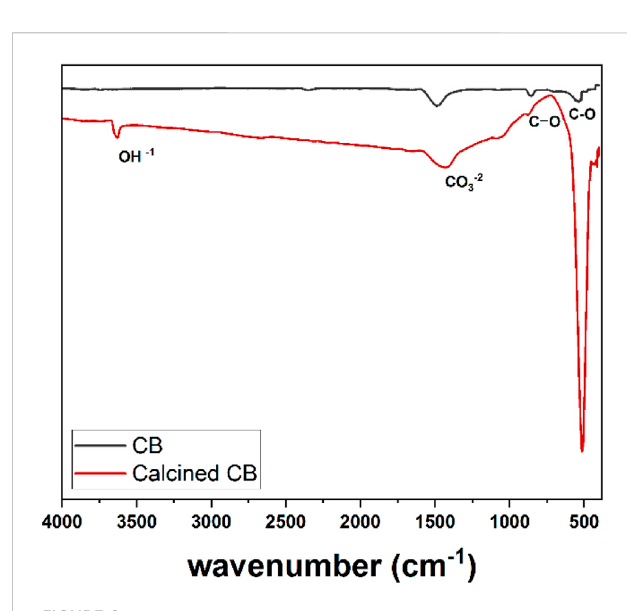
FTIR spectra of pure CFBP (referred to as CB in the picture) and calcined CFBP.